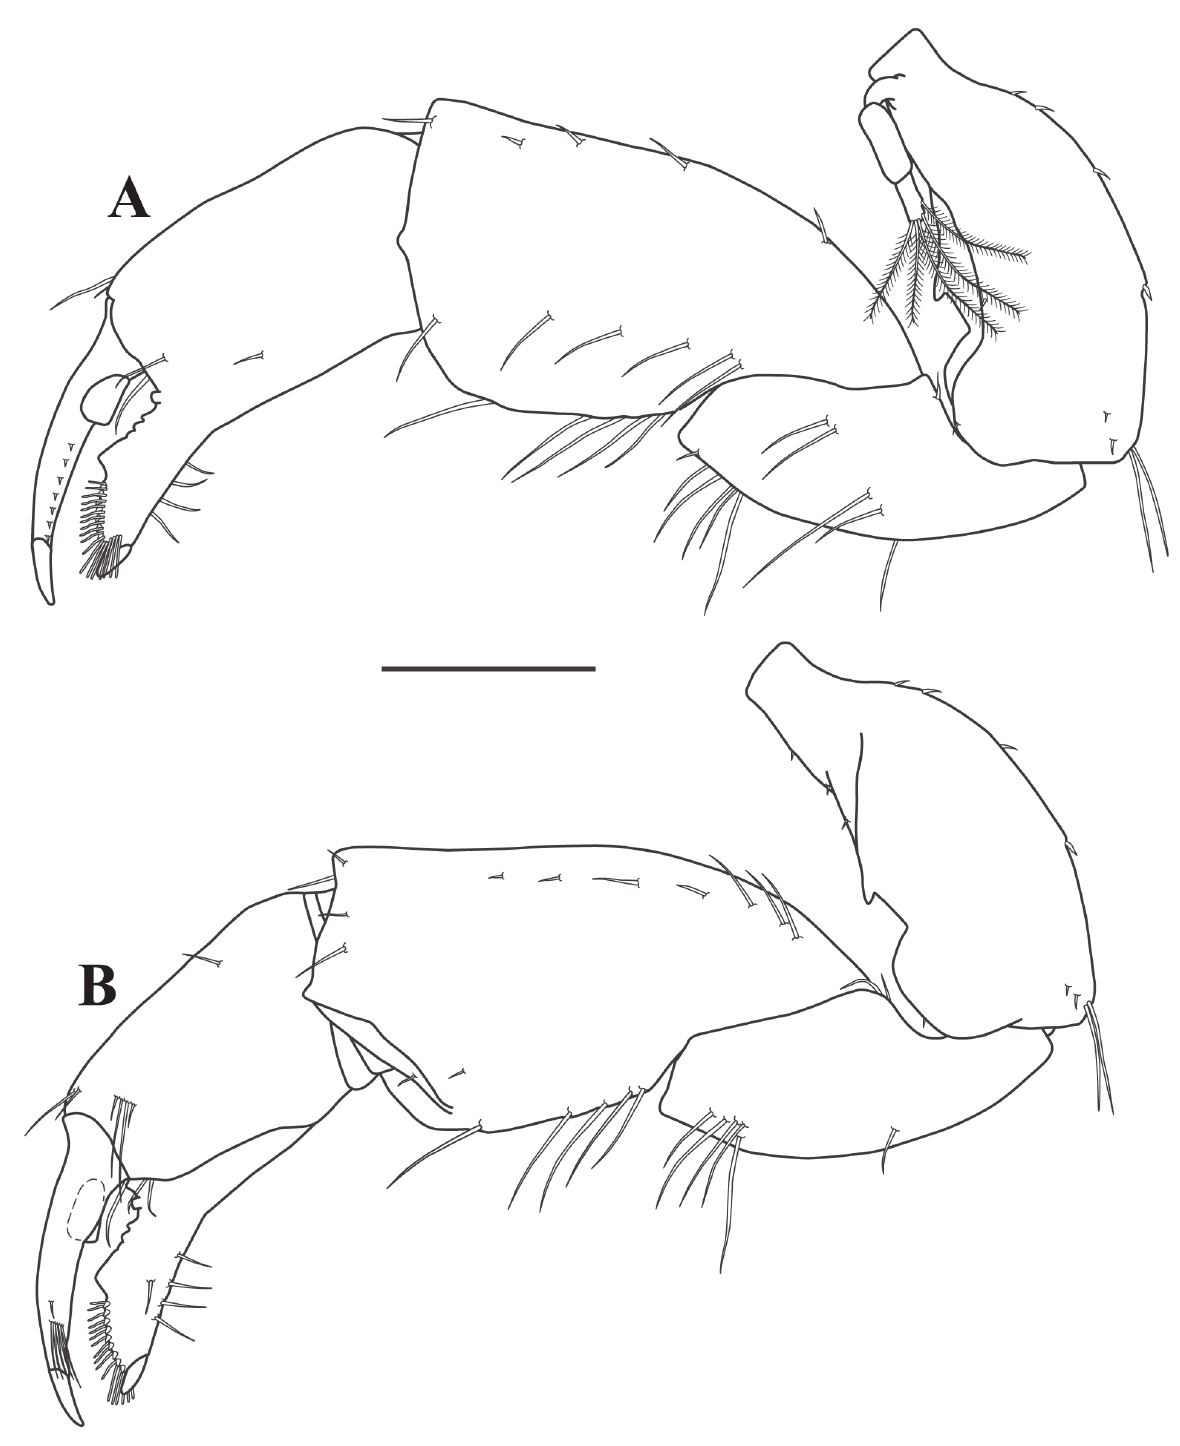
Figure 6. Brachylicoa lui sp. n. holotype female with oostegites and genital cone. A cheliped, lateral view; B cheliped, inner view. Scale bar = 0.5